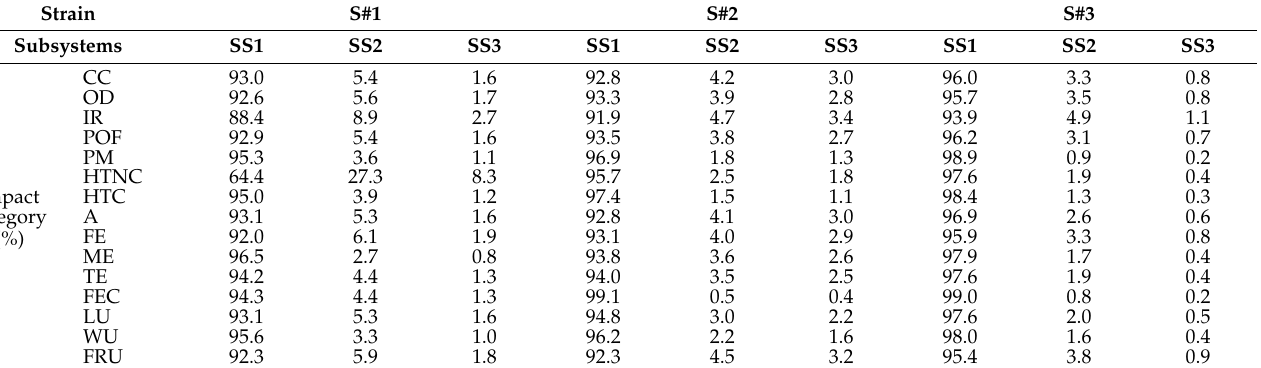
Table 6. Environmental impact distribution (%) per sub-system (SS) in Scenario 1 for S#1,